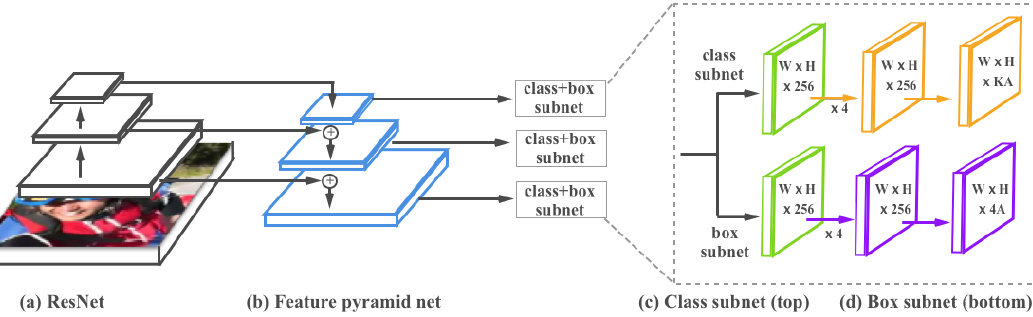
Figure 2. The RetinaNet network architecture uses a Feature Pyramid Network (FPN) [33] backbone on top of a feedforward ResNet architecture [34] ( a ) to generate a rich, multi-scale convolutional feature pyramid ( b ). To this backbone, RetinaNet attaches two subnetworks, one for classifying anchor boxes ( c ) and one for regressing from anchor boxes to ground-truth object boxes ( d